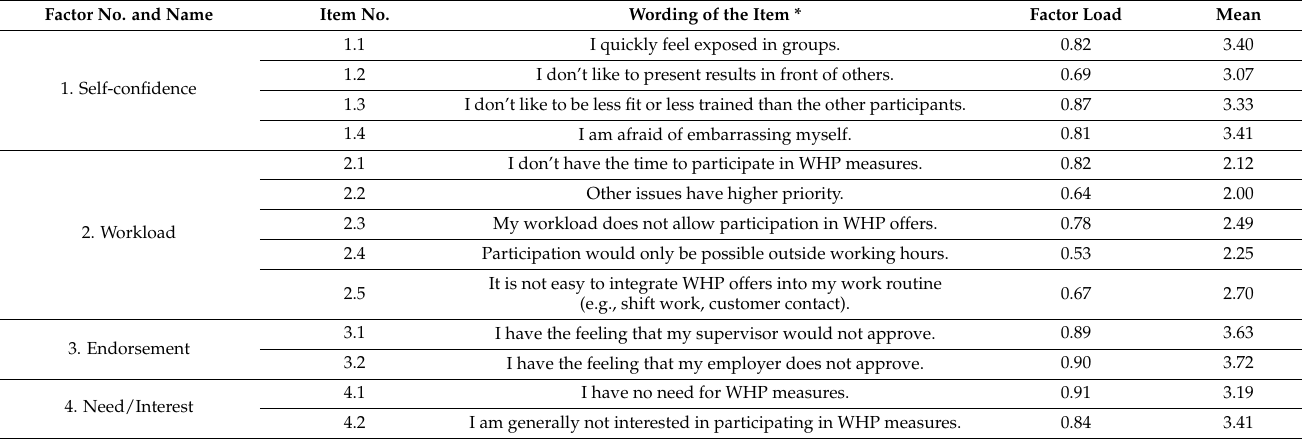
Table 4. Assignment of individual items to underlying factors (reasons for non-participation).